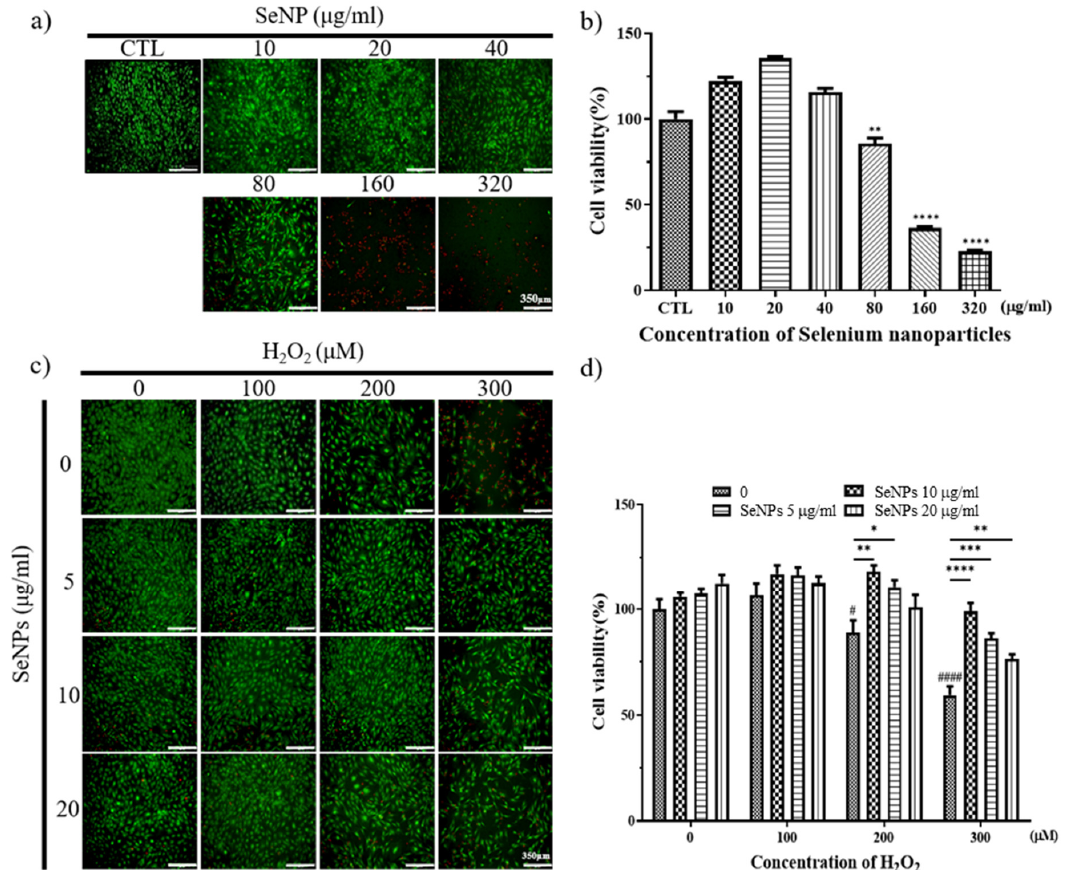
Figure 3. Cell viability and proliferation were determined by live (green) and dead (red) and CCK-8 assays. After cell seeding for 24 h, MC3T3-E1 cells were analyzed using CCK-8 solution and stained using live and dead staining to evaluate cell viability. ( a ) Live and dead staining following treatment with various SeNP concentrations. ( b ) The relative cell viability of MC3T3-E1 cells cultured in different concentrations of SeNPs. ( c ) Live and dead staining following treatment with various SeNP concentrations and H 2 O 2 . ( d ) Cell viability of MC3T3-E1 cells treated with various concentrations of SeNPs and H 2 O 2 . The statistical significance of (b) was calculated using one-way analysis of variance (ANOVA), and (d) was calculated using two-way ANOVA followed by a two-sided Dunnett’s multiple comparison test compared to control (CTL) (scale bar = 350 μ m). * Represents p < 0.05, ** p < 0.01, *** p < 0.001, **** p < 0.0001, # is compared with SeNPs and H 2 O 2 -untreated groups. # Represents p < 0.05, #### p < 0.0001; n = 4.